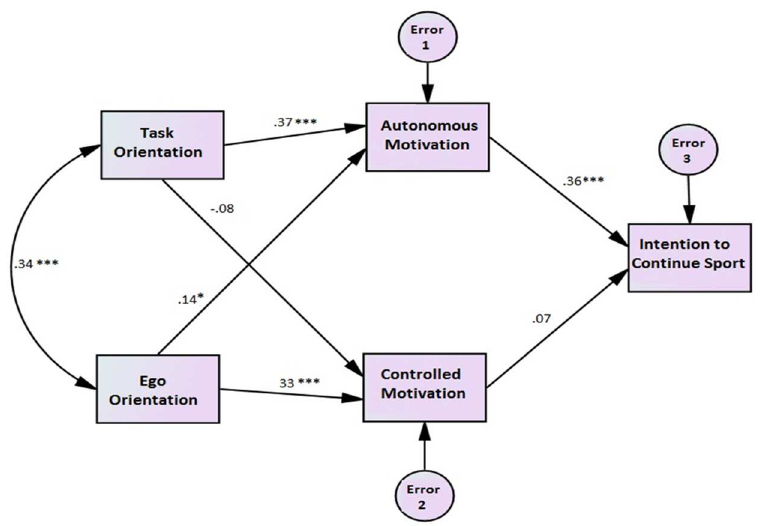
Fig 1. Researchmodel in path coefficient